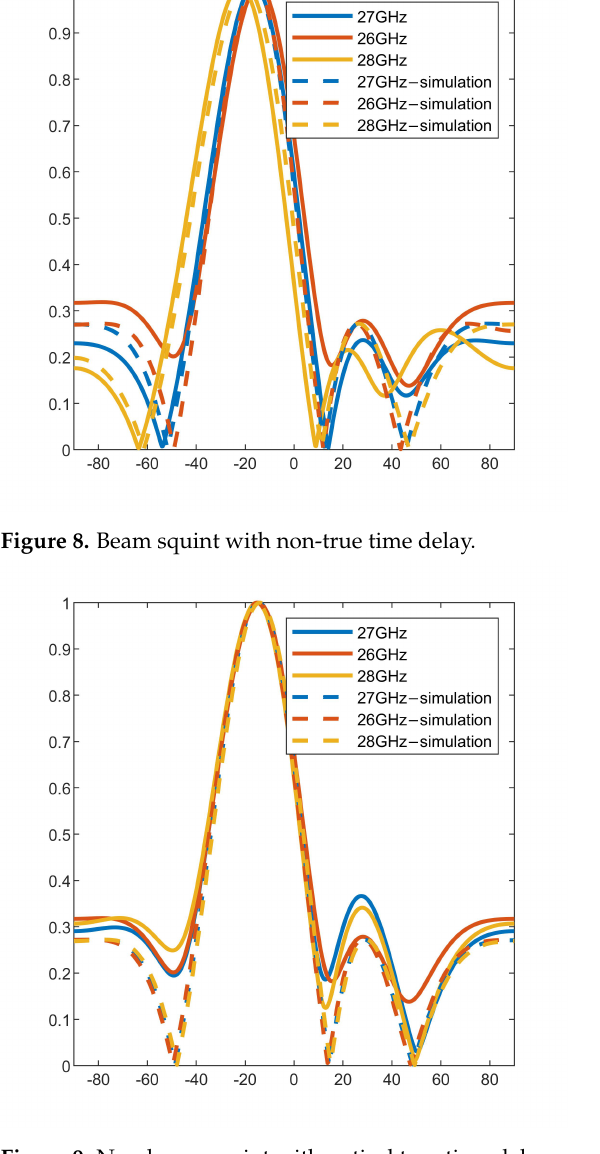
Figure 9. Non-beam squint with optical true time